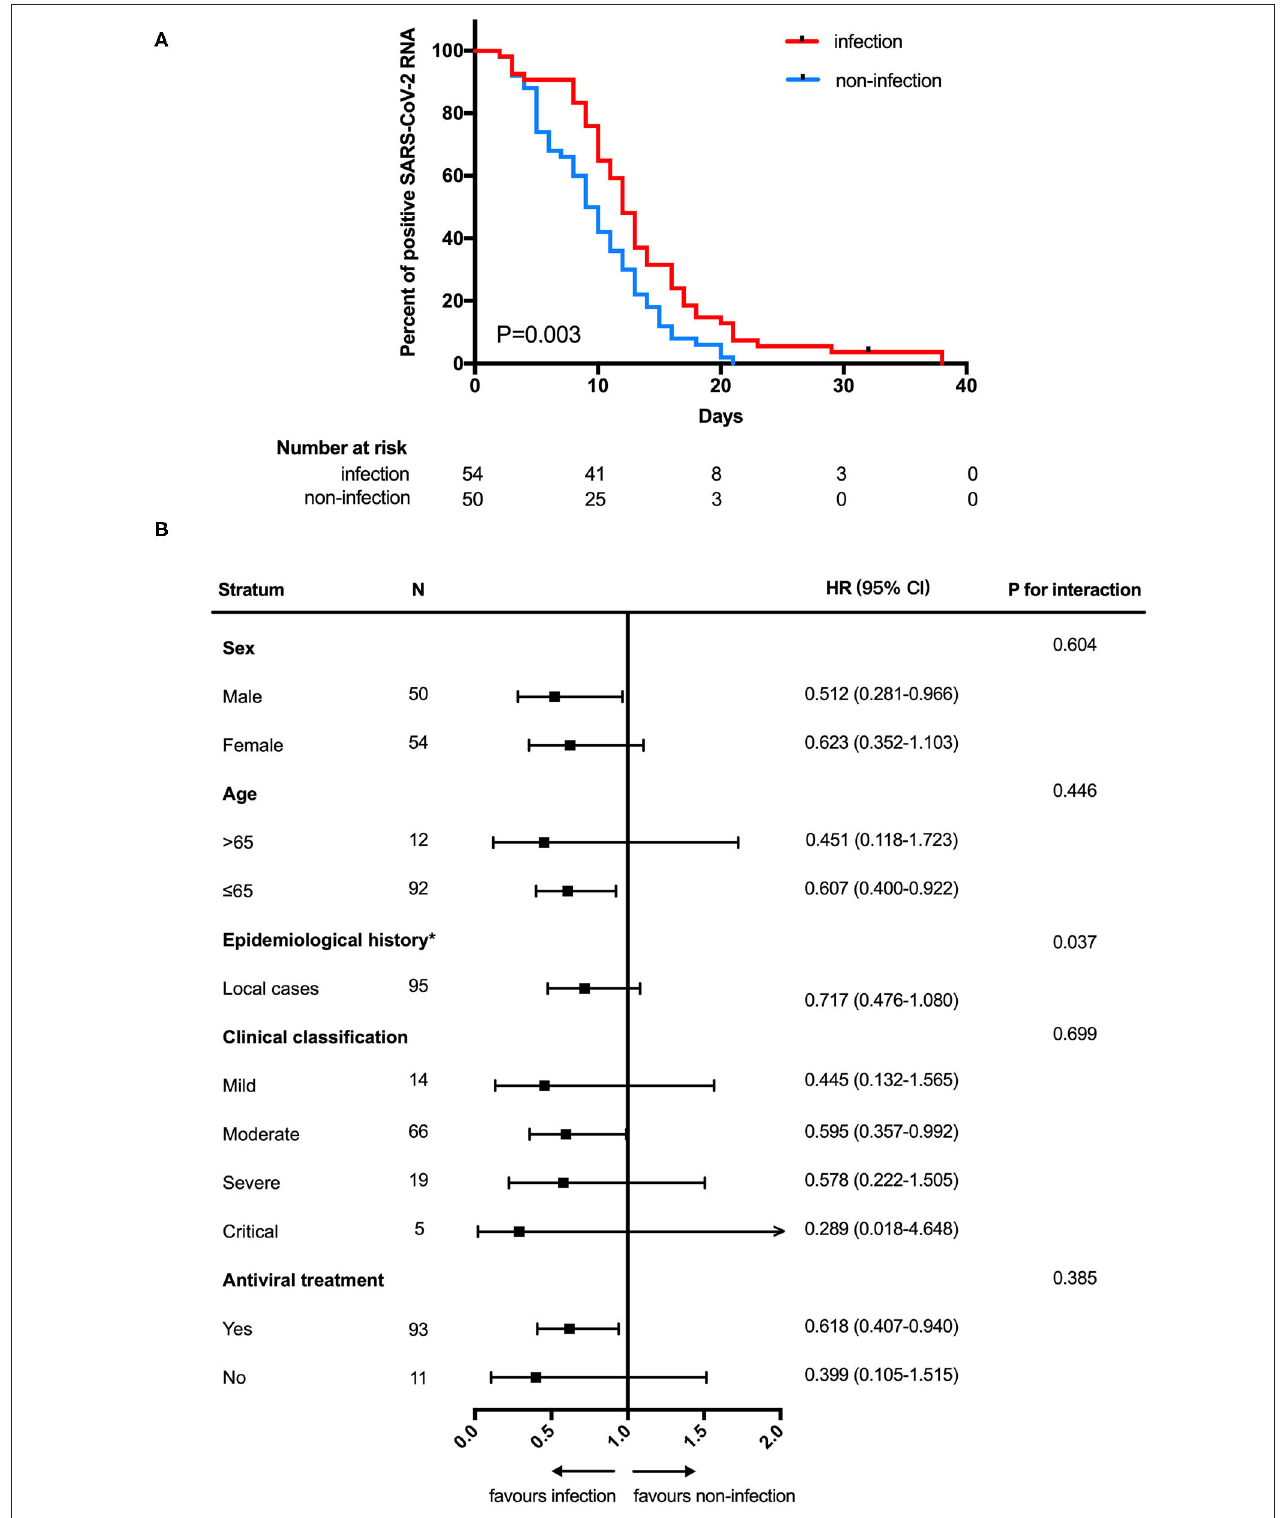
FIGURE 1 | Negative conversion time (A) Kaplan-Meier curve for the duration of SARS-CoV-2 RNA in respiratory tract samples between SARS-CoV-2 gastrointestinal infection and non-infection groups. (B) Subgroup analysis. NCT, negative conversion time; HR, hazard ratio. *The number of patients in the overseas case subgroup was too few for